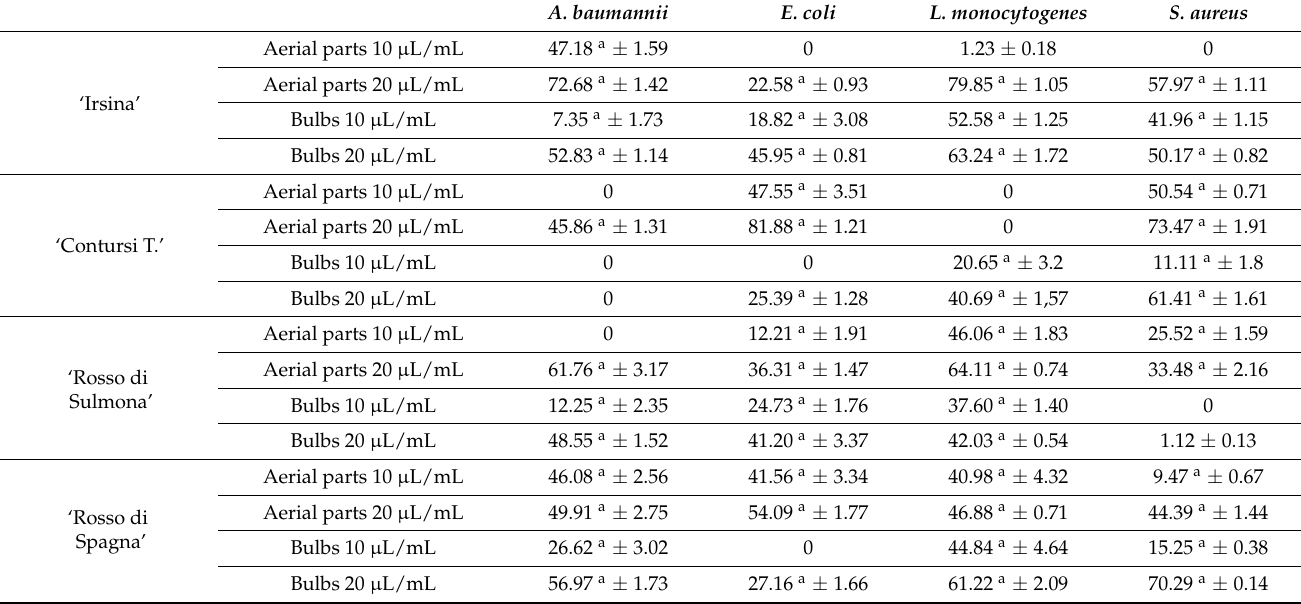
Table 6. Inhibitory activity of the EOs from the cultivars of A. ampeloprasum var. holmense